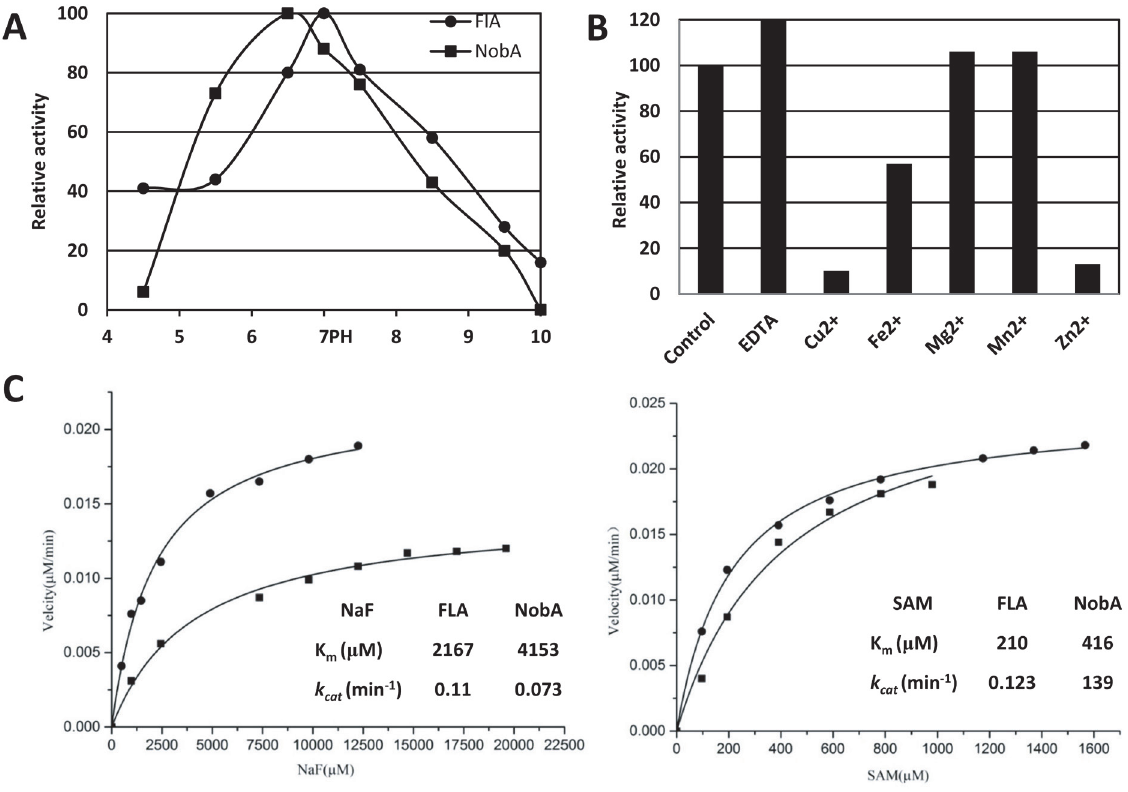
Figure 5. pH and metal ions effect, and kinetic analysis of the fluorination reaction catalyzed by NobA ( ■ ) and FlA ( ● ). ( A ) pH effect on NobA and FlA activity. The optimum activity of NobA at pH 6.5 and FlA at pH 7.0 were individually set as 100%. ( B ) Metal ion effect on NobA activity. The activity of negative control was set as 100%. ( C ) Kinetic analysis of the fluorination reaction. When the concentration of NaF was varied, the SAM was fixed at 0.4 mM, otherwise when the SAM was varied, the NaF was fixed at 5